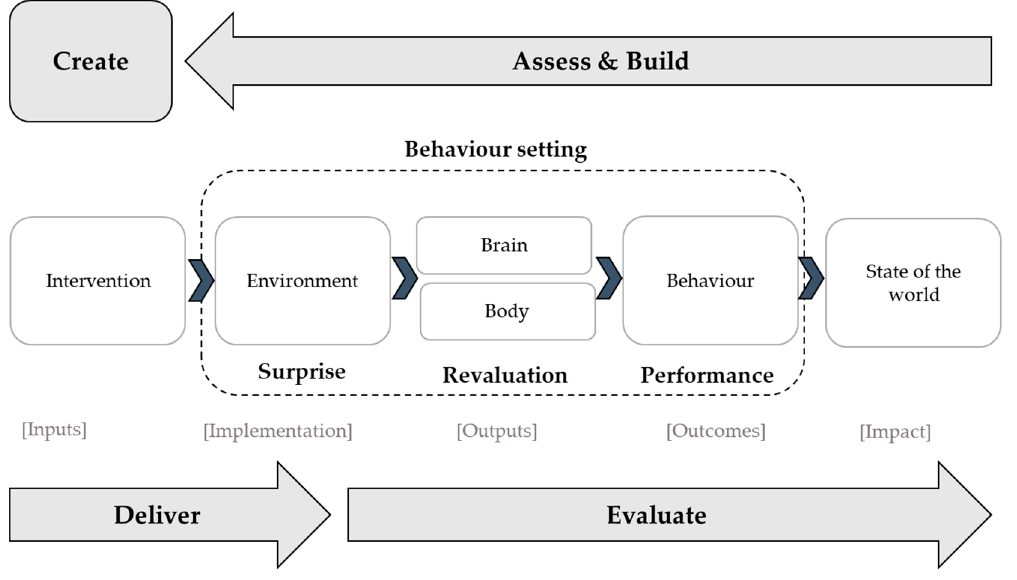
Figure 1. Behaviour Centred Design (BCD) approach (adapted from Aunger et al. 2016) [16].